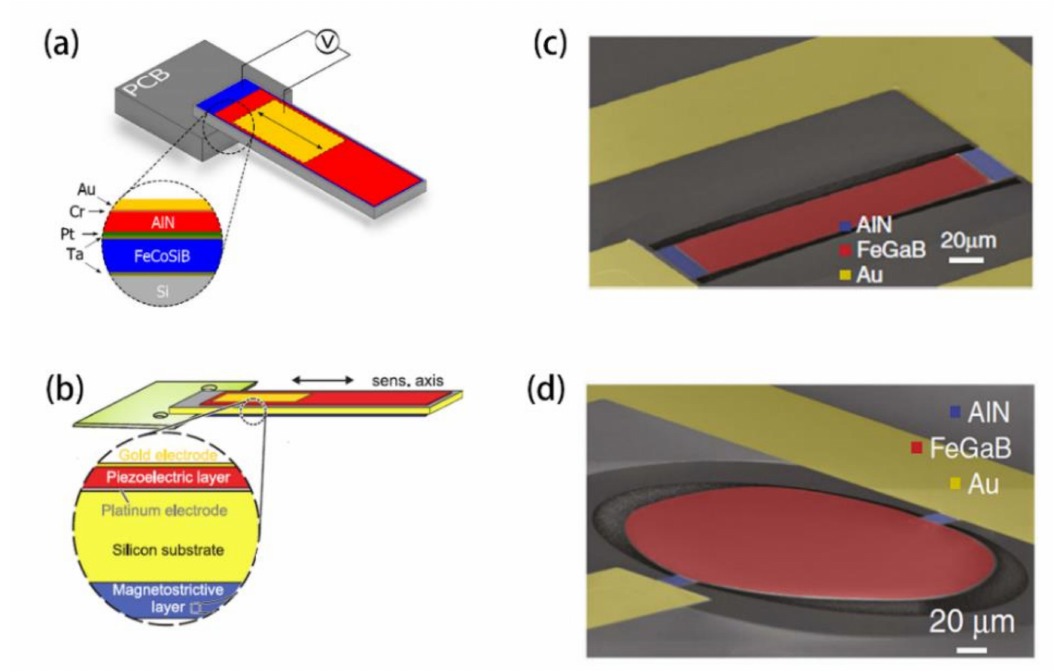
Figure 2. Sketch of ME MEMS cantilever with the functional layer deposited on one side ( a ) [47] and two side ( b ) [50] of silicon substrate. ( c ) Scanning electron microscopy (SEM) images of the ME nano plate resonator. ( d ) Scanning electron microscopy (SEM) images of the fabricated ME thin-film bulk acoustic wave resonators. The red and blue areas show the suspended circular plate and AlN anchors. The yellow area presents the electrode